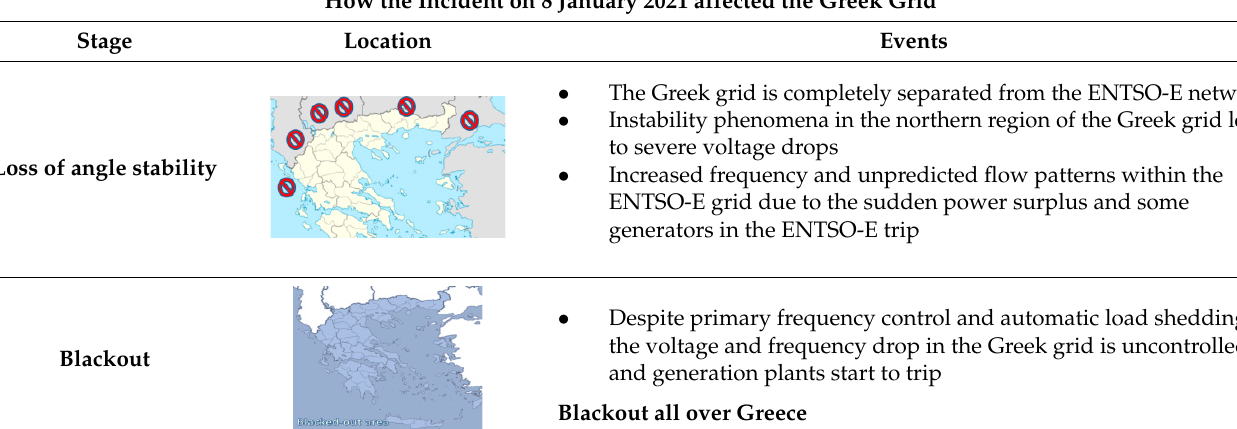
• Despite primary frequency control and automatic load shedding, the voltage and frequency drop in the Greek grid is uncontrolled and generation plants start to